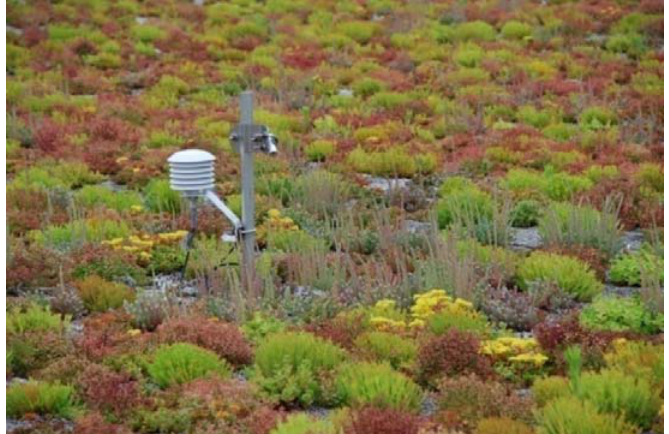
Figure 5. Close-up view of 1-year old sedum plant cover on the green roof in figure